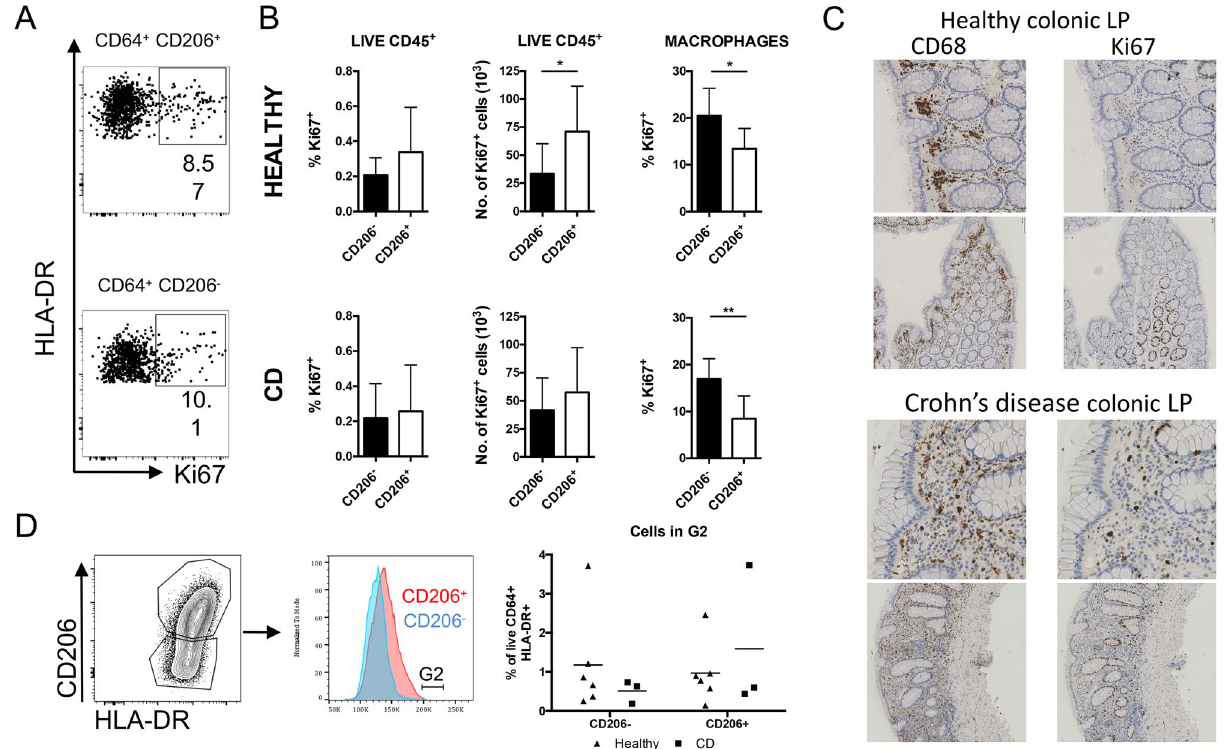
Figure 6. Proliferative capacity of human colonic macrophages. ( A ) Identification of human colonic Ki67 + macrophages isolated from lamina propria tissue of healthy colon biopsies. ( B ) Quantification of Ki67 + CD206 + and Ki67 + CD206 − macrophage populations in healthy and CD tissue. Error bars show + SD. n = 9 for both CD206 − and CD206 + . ( C ) Immunohistochemical staining of representative healthy and CD colonic cells cells for CD68 (left column) and Ki67 (right column). ( D ) Proliferation comparison between healthy and CD tissue. Example of gating, and frequencies of CD206 − and CD206 + macrophages in G2 in healthy and CD